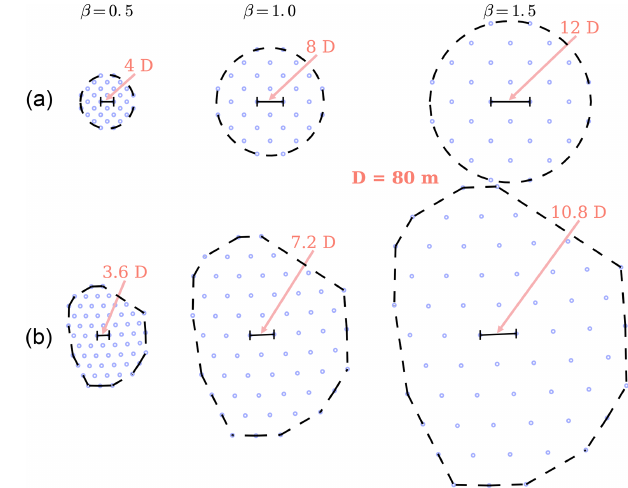
Figure 8. The six wind farm boundaries and associated baseline layouts optimized in this study. The same two layouts were multi- plied by a spacing multiplier, β = 0 . 5, 1 . 0, and 1 . 5, which changed the wind farm size and the average spacing between wind turbines. Panel (a) is the 32-turbine, circular wind farm, and panel (b) is the 60-turbine, Princess Amalia wind farm. The turbine spacings, in baseline rotor diameters, are also displayed for each spacing mul- tiplier in this figure. The circles representing the turbine locations have a diameter of 80m in this figure, equal to the baseline rotor